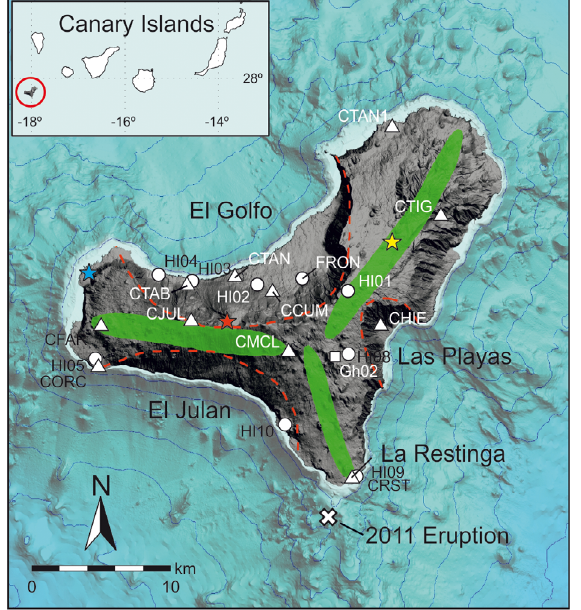
Figure 2. Images of volcanic products emitted during the 2011-2012 eruption. (a) Hot scoriaceous blocks and “lava balloons” floating on the sea surface during the eruption; (b) “coconut-like” bomb con- sisting of an outer basanite crust embedding a pumiceous xenolith [Troll et al. 2011, Meletlidis et al. 2012, Sigmarsson et al. 2012, Del Moro et al. 2015]; (c) example of the juvenile ash and fine lapilli sampled in water column on November 5, 2011, and February 12, 2012; (d) floating lava block erupted during the first days of the eruption; (e) elliptical-shaped “lava